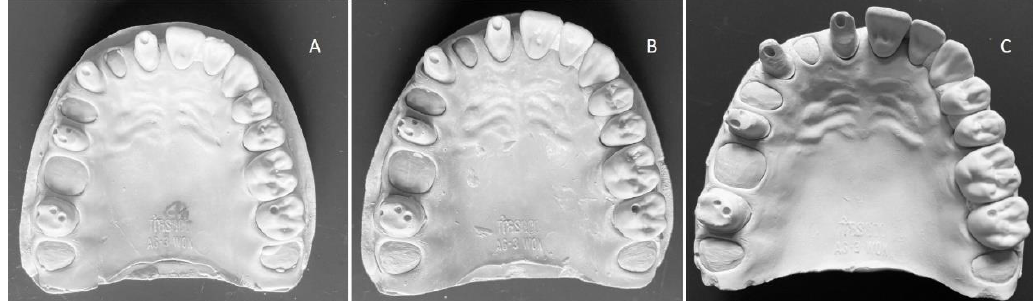
Figure 2. Casts fabricated using the conventional impression techniques. ( A ) Alginate impression, ( B ) Alginate Substitute impression and ( C ) PVS impression.